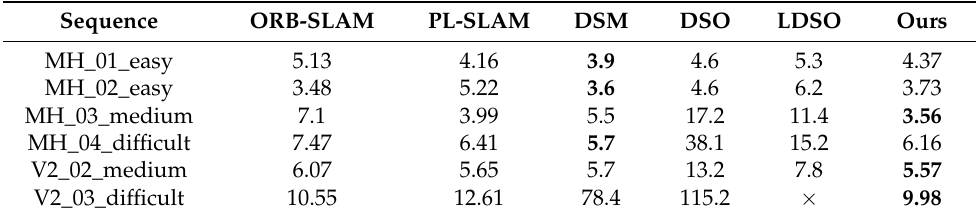
Table 2. Comparison of RMSE and time-consuming of two algorithms on EuRoC dataset.